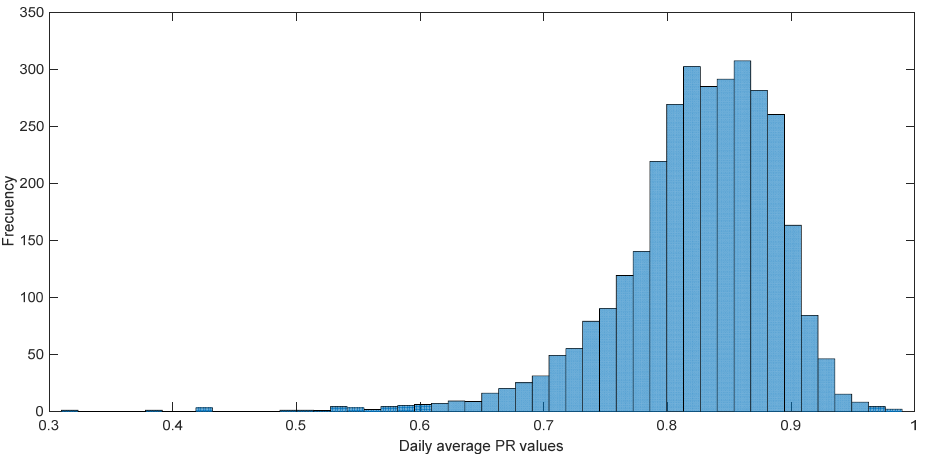
Figure 5. Histogram corresponding to the daily average values of the performance ratio ( PR ) for the inverter together with the associated modules over the period 2011–2020.